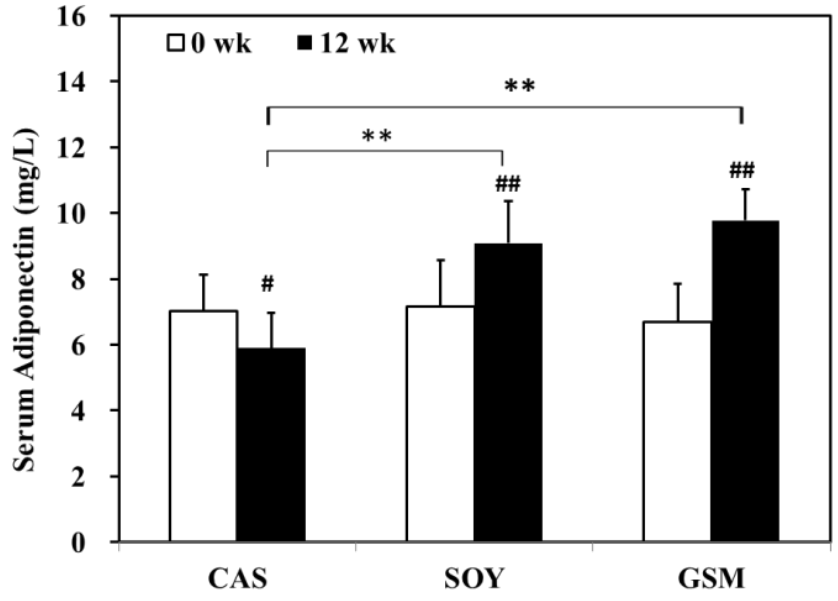
Figure 3. The effect of different dietary proteins on serum adiponectin. Serum adiponectin showed no significant difference among all three groups at the beginning of the study. During the 12-week period, serum adiponectin in the CAS group decreased significantly whereas that in SOY and GSM group increased significantly as compared to their respective baseline levels. Among groups, SOY and GSM groups demonstrated higher levels of serum adiponectin than that of CAS group at the end of the study. One-way ANOVA followed by an LSD-test was used to detect significant differences of the means, ** p < 0.001 versus CAS group; # p < 0.05 versus baseline; ## p < 0.001 versus baseline.